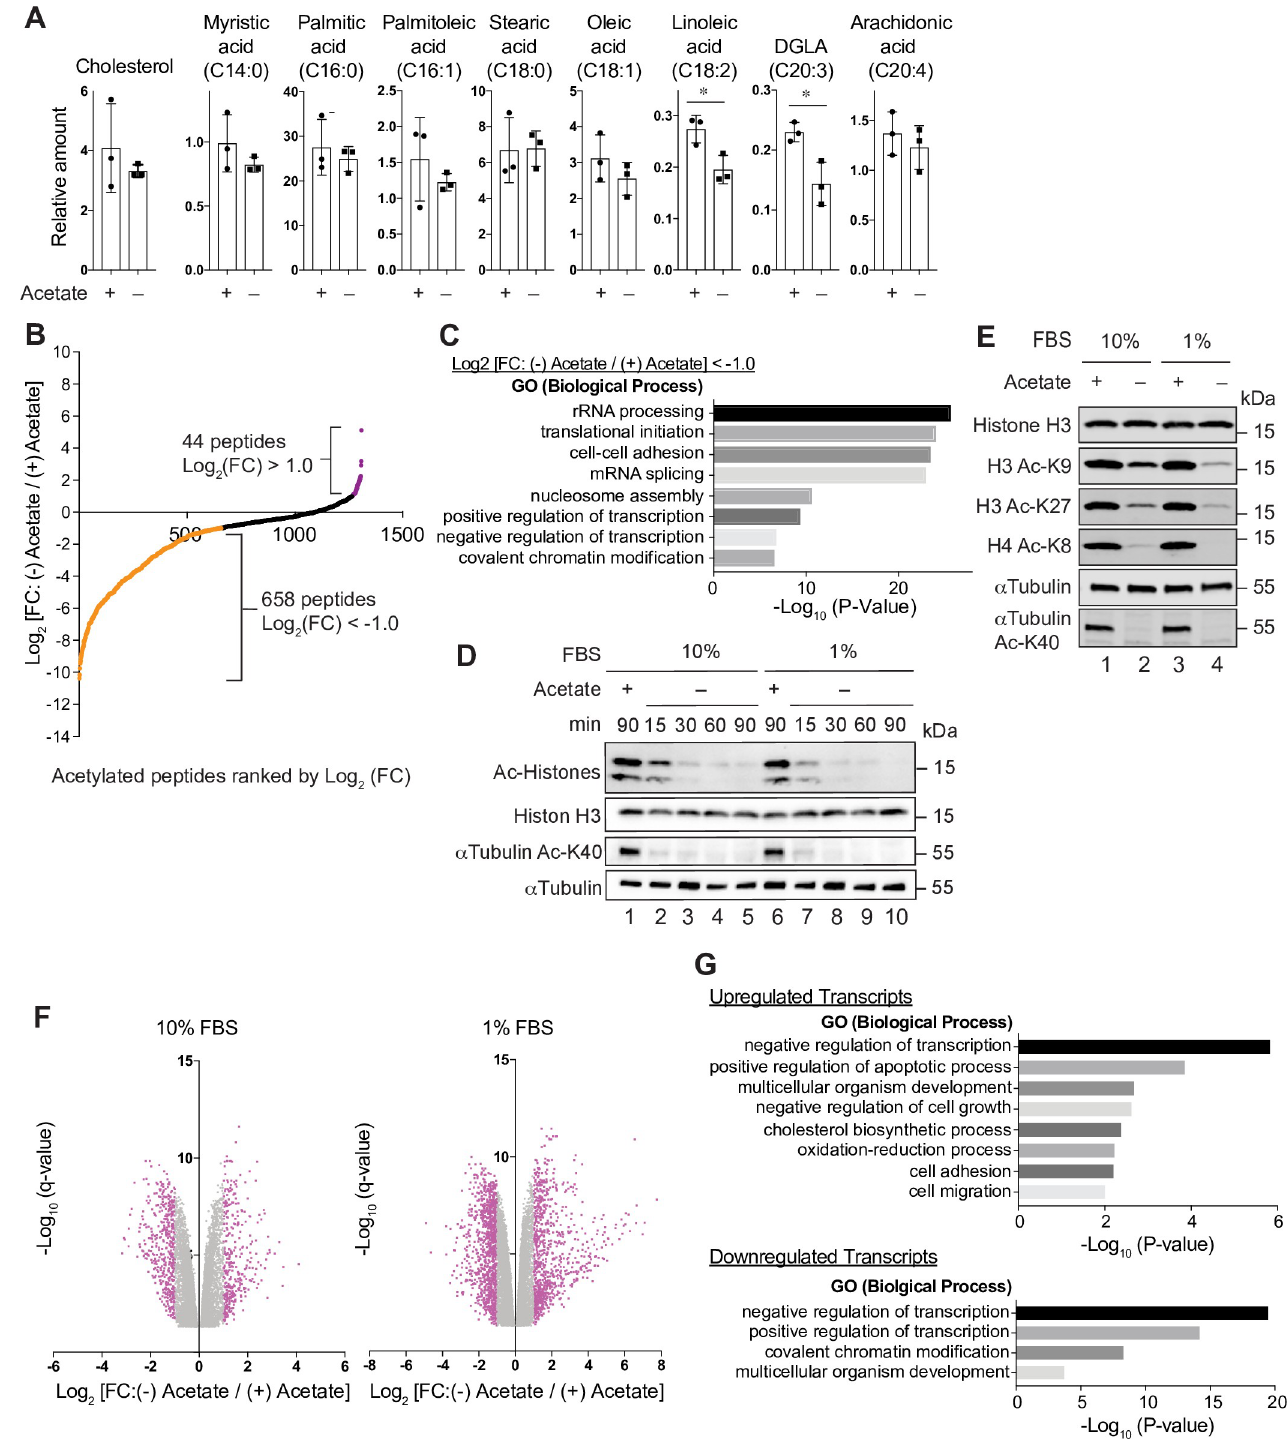
Fig 2. Alterations in lipid synthesis, acetylation, and gene expression following acetyl-CoA depletion. (A) Quantification of total cholesterol and fatty acids in ASA-KO cells cultured for 4 hours in 1% FBS containing media with or without 20-mM acetate. Data are shown as mean of 3 biological replicates. � P < 0.05 (Unpaired t test). (B) Plot of acetylated peptides ranked by log 2 FC 90 minutes after acetate removal in ASA-KO cells. Values are from S1 Table, column B (mean of 2 independent technical replicates). (C) GO analysis for putative deacetylated peptides identified in the acetylome analysis. Enriched representative biological processes are shown. (D) Immunoblotting for the indicated acetylated proteins in ASA-KO cells cultured in 10% or 1% FBS containing media with or